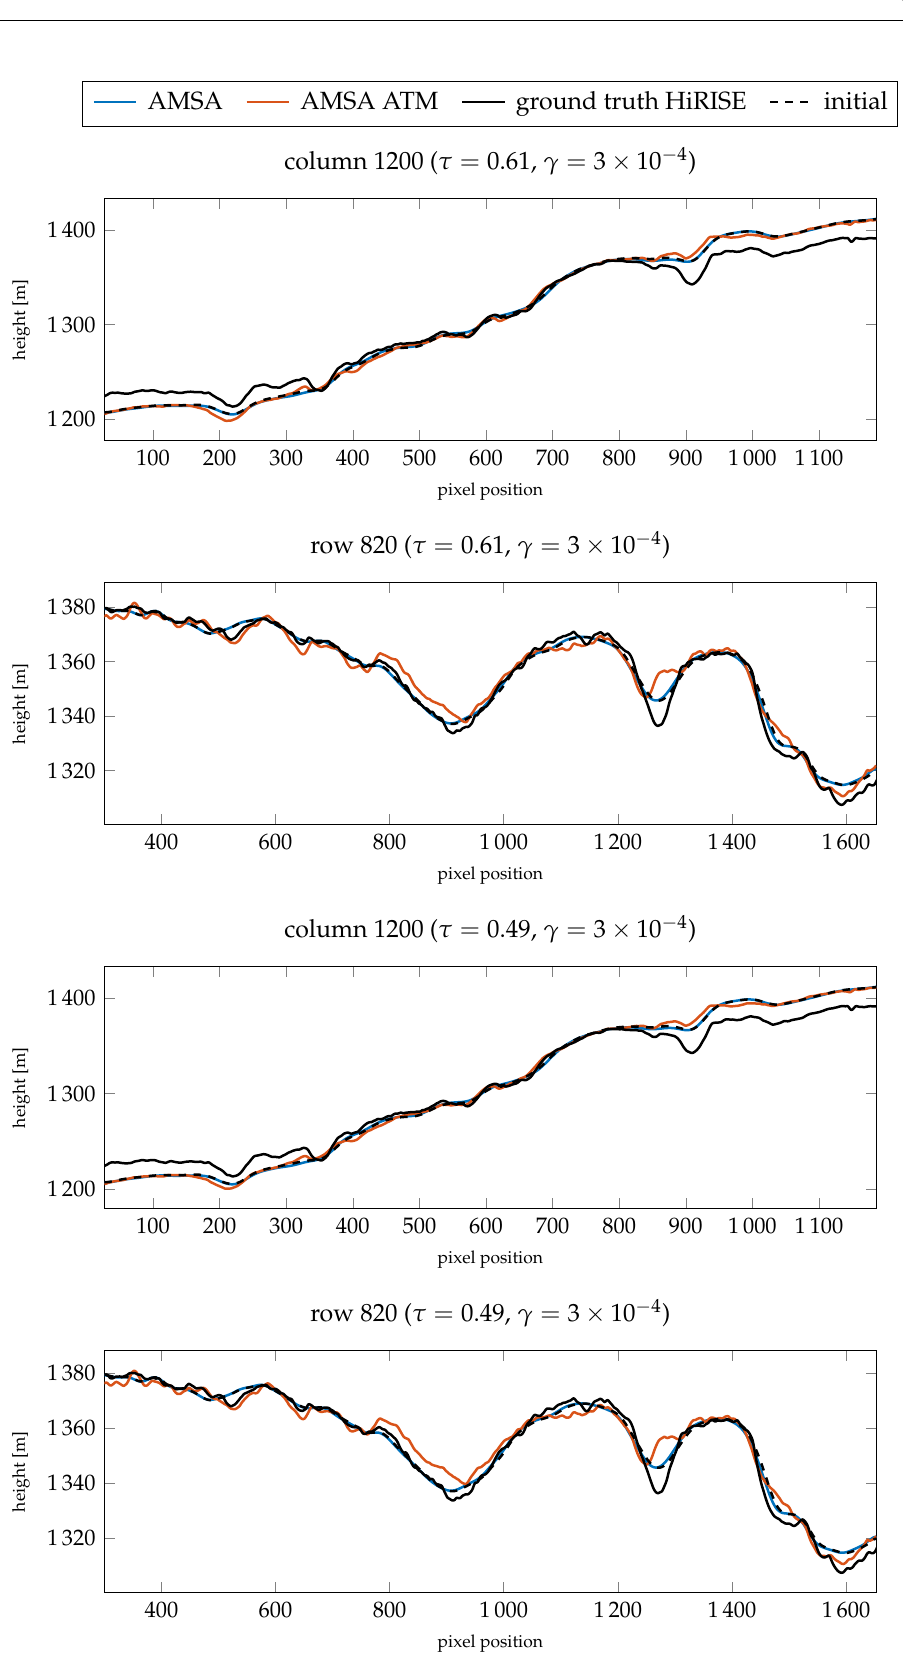
Figure A2. Absolute heights for image K13_058554_2232_XN_43N103W (medium atmospheric conditions) not displayed in the main